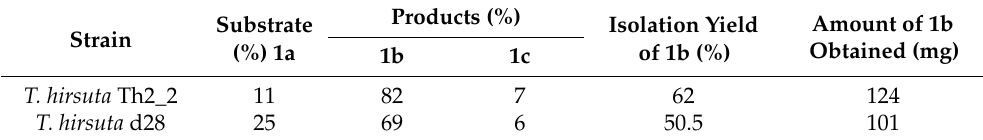
Table 5. Summary of the biotransformation process on a preparative scale with 200 mg of isosafrole ( 1a ) after 11 days (percentage values according to the GC). Products (%) Isolation Yield Amount of 1b Substrate Strain Obtained (mg)1b 1c (%) 1a of 1b (%) T. hirsuta Th2_2 11 82 7 62 124 T. hirsuta d28